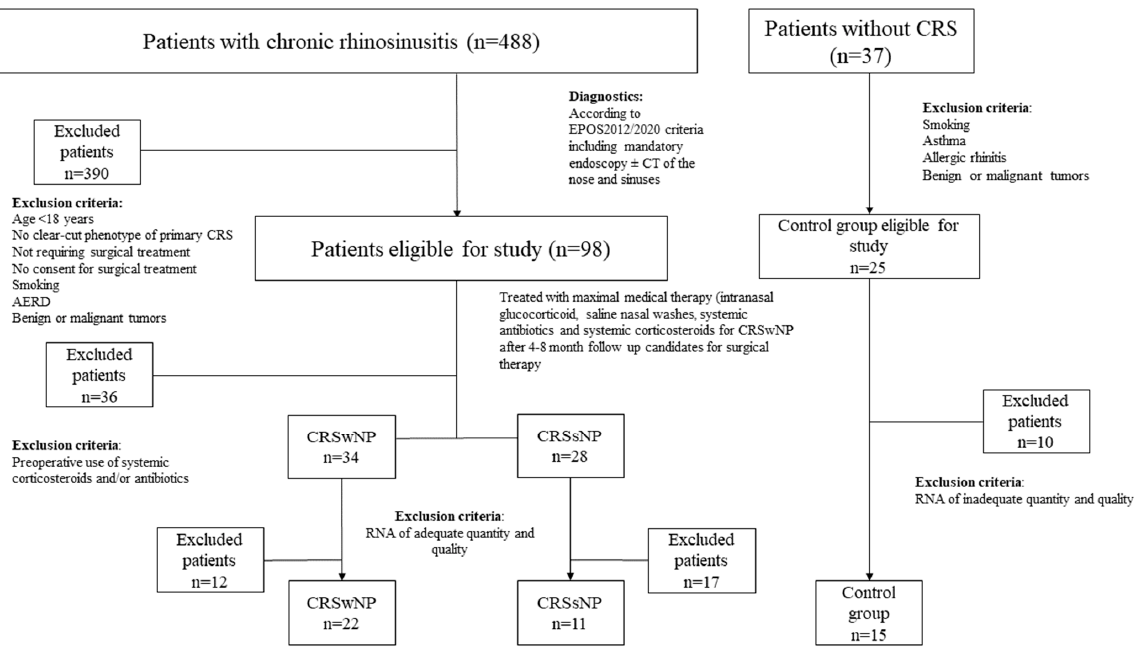
Figure 5. The inclusion fl owchart.